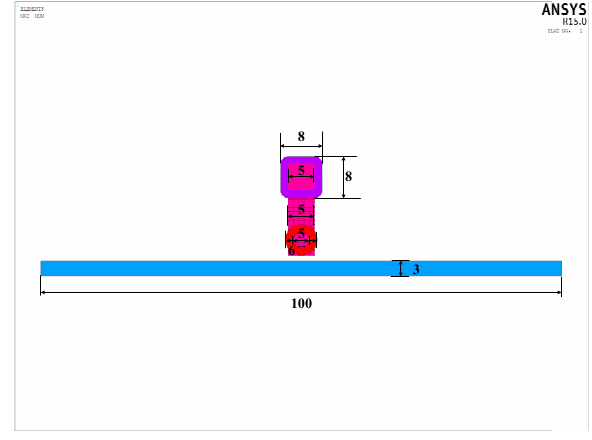
Figure 4. Side view of 3D simulation model.